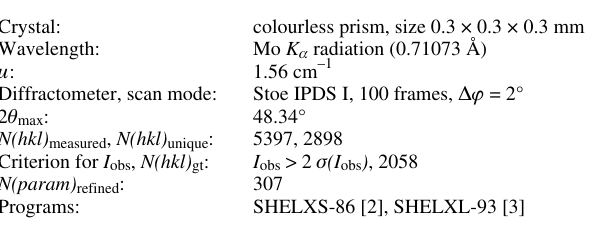
Table 1. Data collection and handling.